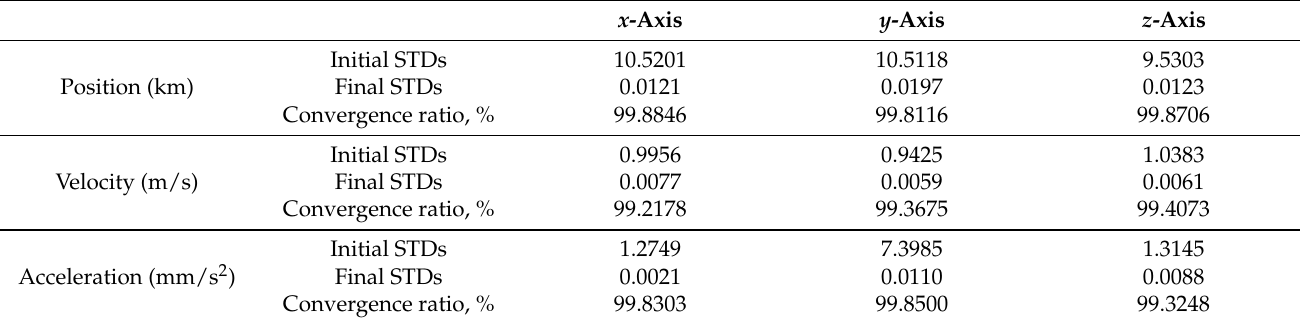
Table 5. Convergence ratios of the non-maneuvering